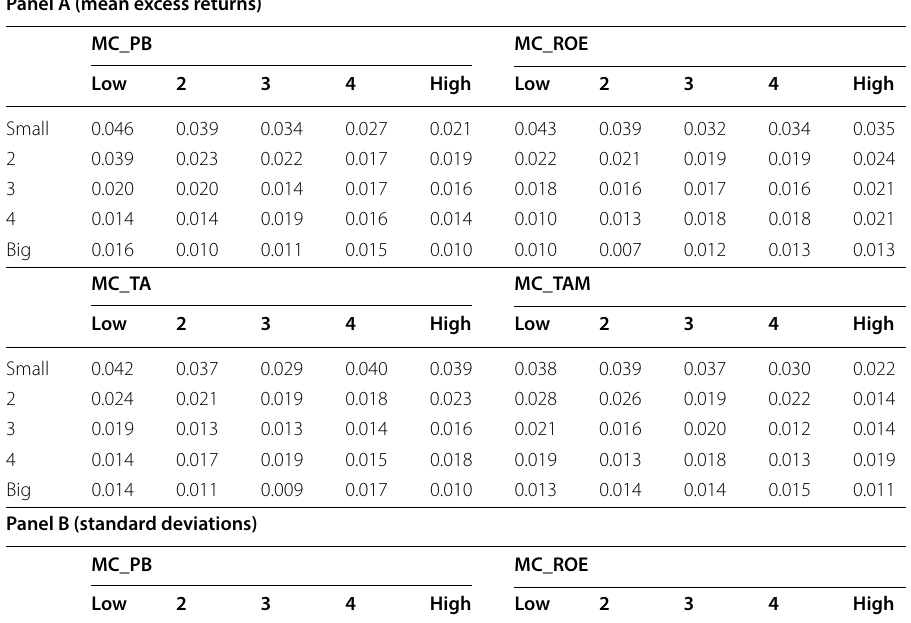
Table 3 Summary statistics of 25 portfolios formed on MC_PB, MC_ROE, MC_TA and MC_